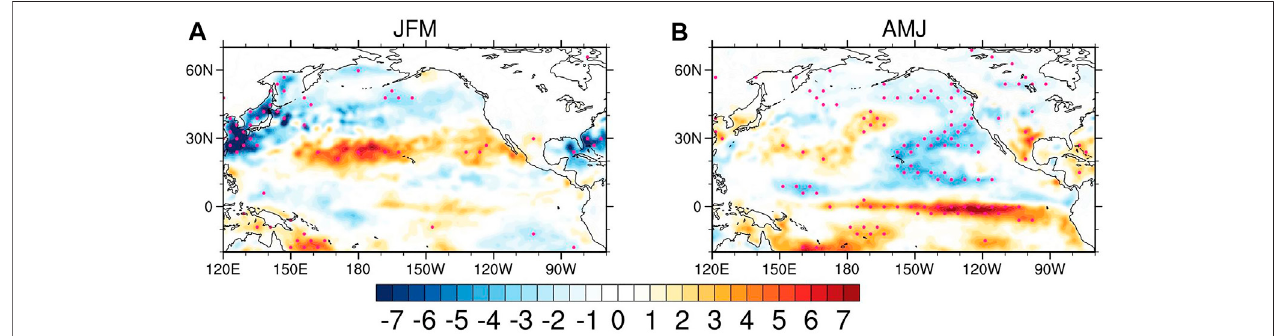
FIGURE 8 | Regression of surface upward latent heat fl ux (shading; W m − 2 ) anomalies in (A) JFM, (B) AMJ onto the normalized JFM SHI index. Stippled regions indicate latent heat fl ux anomalies signi fi cant at the 90% con fi dence level. Downward fl uxes are positive, indicating the transfer of energy from the atmosphere to the